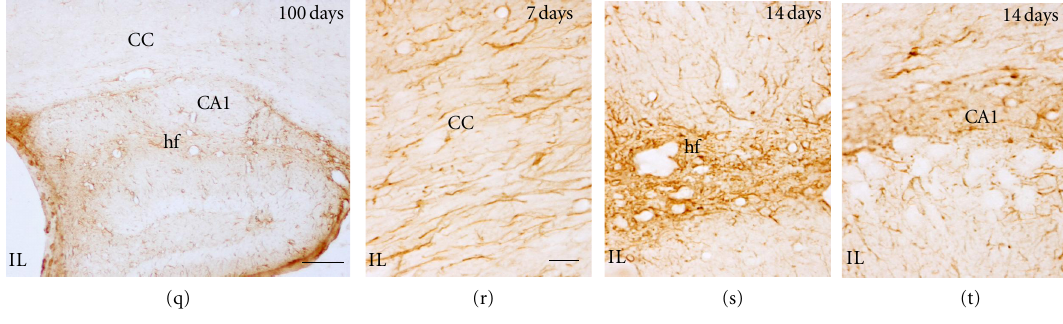
Figure 6: GFAP immunostaining showing age-matched controls and e ff ects of H/I on the hippocampus and corpus callosum. Developmental changes in astrocytes are observed in control animals (a–c), showing a progressive change from more activated astrocytes (a) to resting astrocytes at P14 (b) and P21 (c). Activated astrocytes increase in the contralateral (CL) (d–f), and ipsilateral hemisphere (IL), from 3 hours (hrs) to 100 days after hypoxia (g–t). At 3 hrs (g), astrocyte activation can be seen in the hippocampal fissure, CA and corpus callosum. At 48 hrs (i, m) and 72hrs, (j) CA layer degeneration is observed. From 7 days (n) to 100 days (t), there is a decrease of the astrocytes activation in the corpus callosum, but in the hippocampus the reduction in astrogliosis starts at 30 days after hypoxia (p). Scale bars (low magnifications: a–j, n–p and t) = 100 μ m; scale bar in all other micrographs = 20 μ m. CA1: cornu ammonis 1; CC: corpus callosum; hf: hippocampal